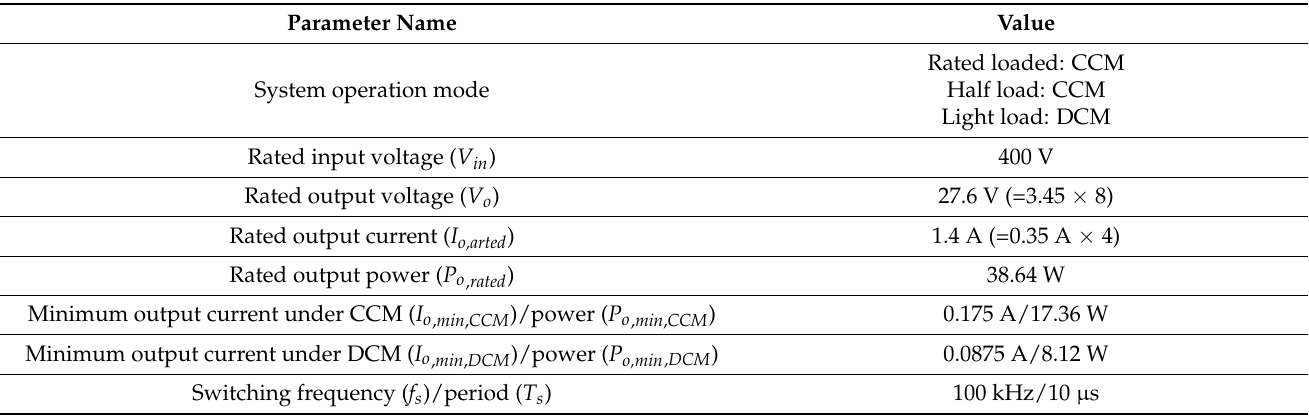
Figure 11. System configuration diagram. Table 1. System specifications.